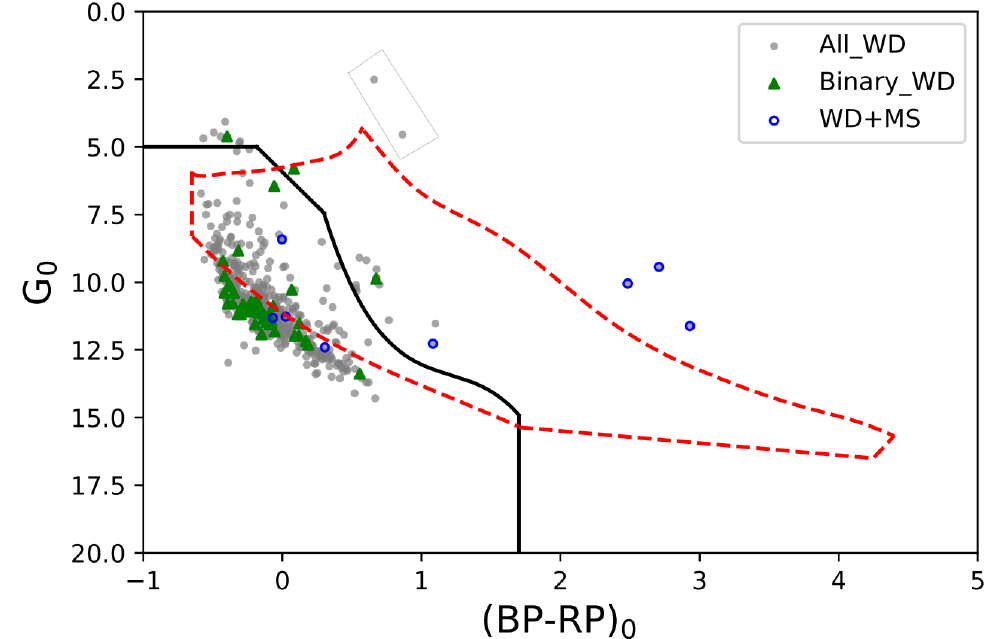
Figure 9. The distribution of the WD binary candidates and the sample of general WDs on H–R diagram ( ( BP − RP ) 0 vs. absolute G 0 ). Green triangles: WD binary candidates; blue hollow circles: WD + MS stars obtained from spectroscopic examination; grey dots: total sample of DA WDs. The solid black line shows a color-cut and absolute magnitude selection scheme for searching for WDs using Gaia data proposed by Ref. [27]. The red dashed lines show the color–magnitude diagram selection scheme for searching for WDMS candidates based on Gaia EDR3 data by Ref. [28]. The two stars in the gray box are main-sequence stars that we found by examining their spectra. Table 3. DA + M binaries and four